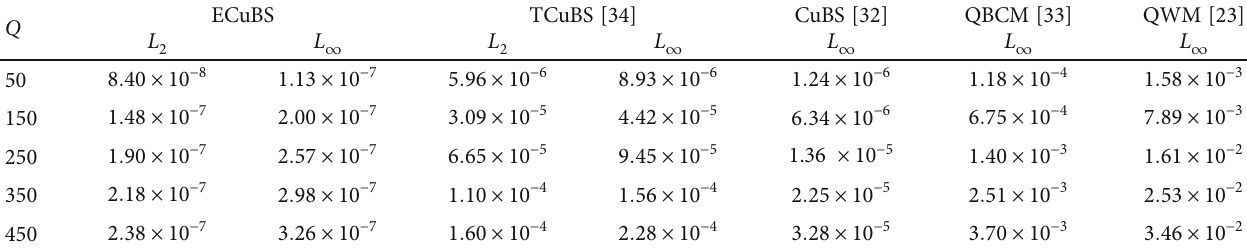
Table 1: Error comparison for Example 5 when Δ t = 10 − 5 ,and N = 10 .